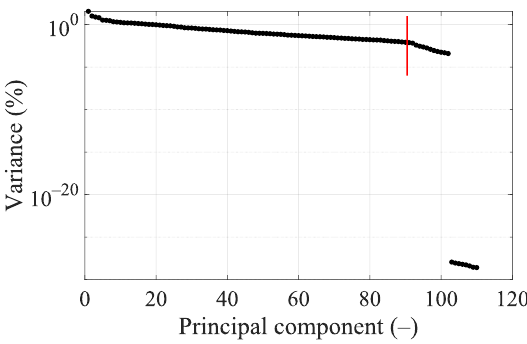
Figure 7. Principal components’ variance graph for DataSet 1 at 1 GHz. The red line indicates data reduction to 90 dimensions.